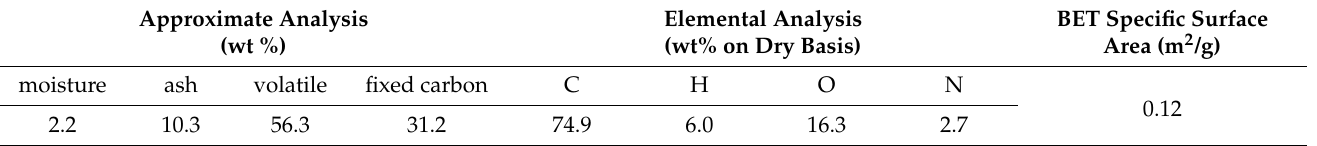
Table 4. Properties of phenolic resin